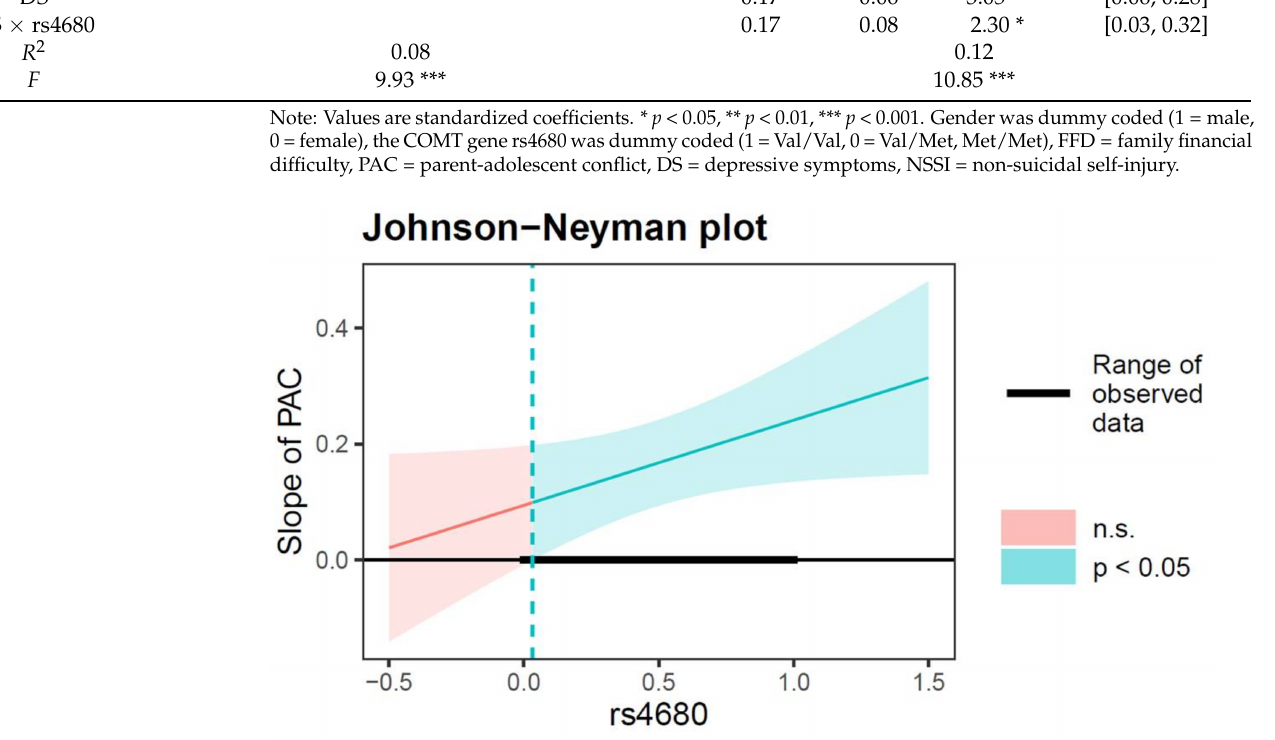
Figure 2. Interactive effect of PAC and rs4680 polymorphism on adolescent depressive symptoms. The green-red line indicates the simple slope of PAC contribute to depressive symptoms. Note: The green line represents the region of significance for the conditional association. Shaded area = confidence interval, PAC = parent-adolescent conflict, n.s. = not significant, the rs4680 value (1 = Val/Val, 0 = Val/Met,